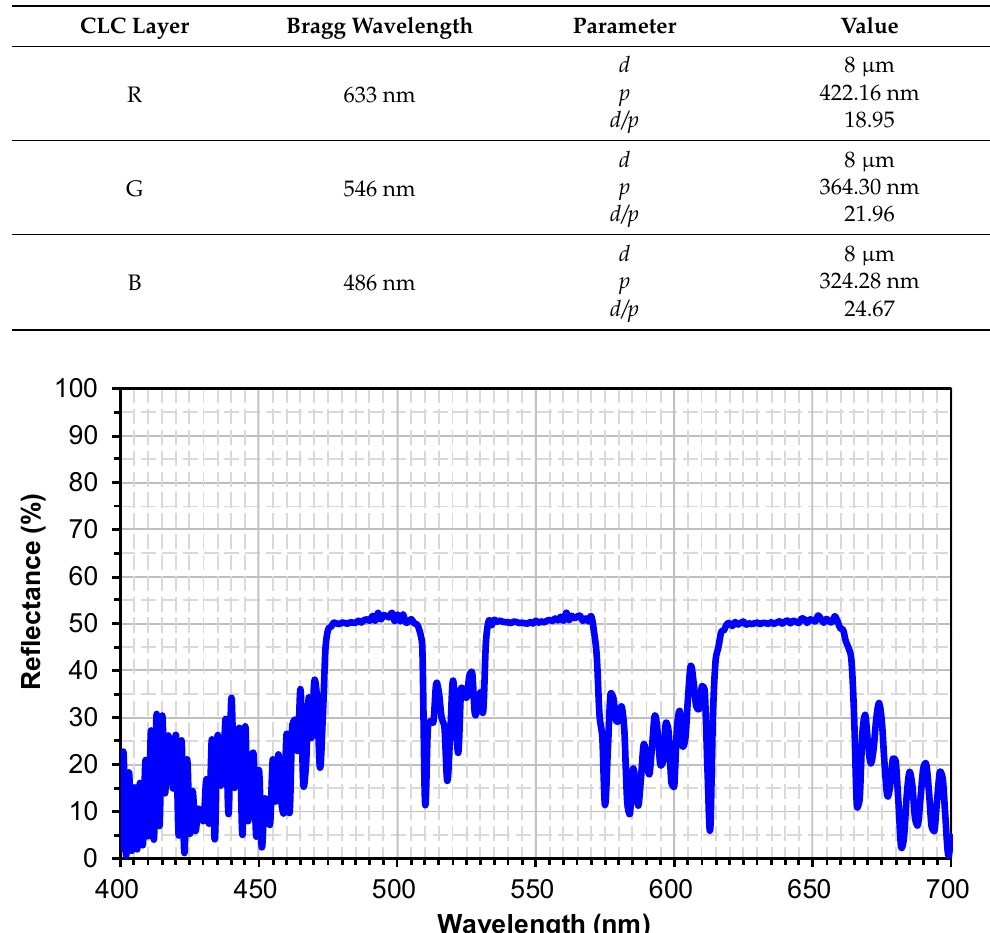
Figure 6. Reflectance with respect to the wavelength. The spectral bandwidth of reflectance from 45% to 50% for the R/G/B color is 47/40/34 nm, which is compatible with the light-emitting diodes as the light source.